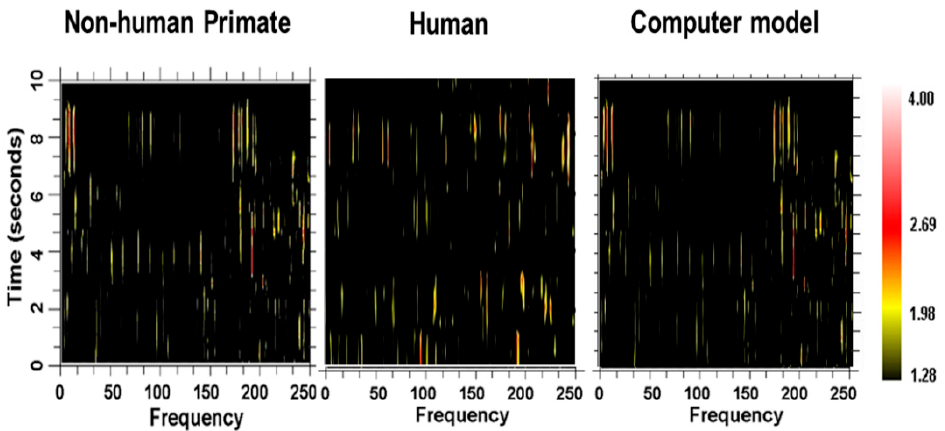
Figure 24. Spectrograms showing the amount of activity (power) at different frequencies over time. The power is represented as the z -score difference (color scale) over a randomized train of action potentials (spike train). At each point in time, the train of action potentials has a specific set of frequencies over a range of frequencies. Also, the train of action potentials appears to be stable in their frequency content and then change (bifurcate) to other sets of frequencies. Spectrograms of actual recordings in the globus pallidus externa of a nonhuman primate, the subthalamic nucleus in a human, and a neuron in the computer model of the network are shown.